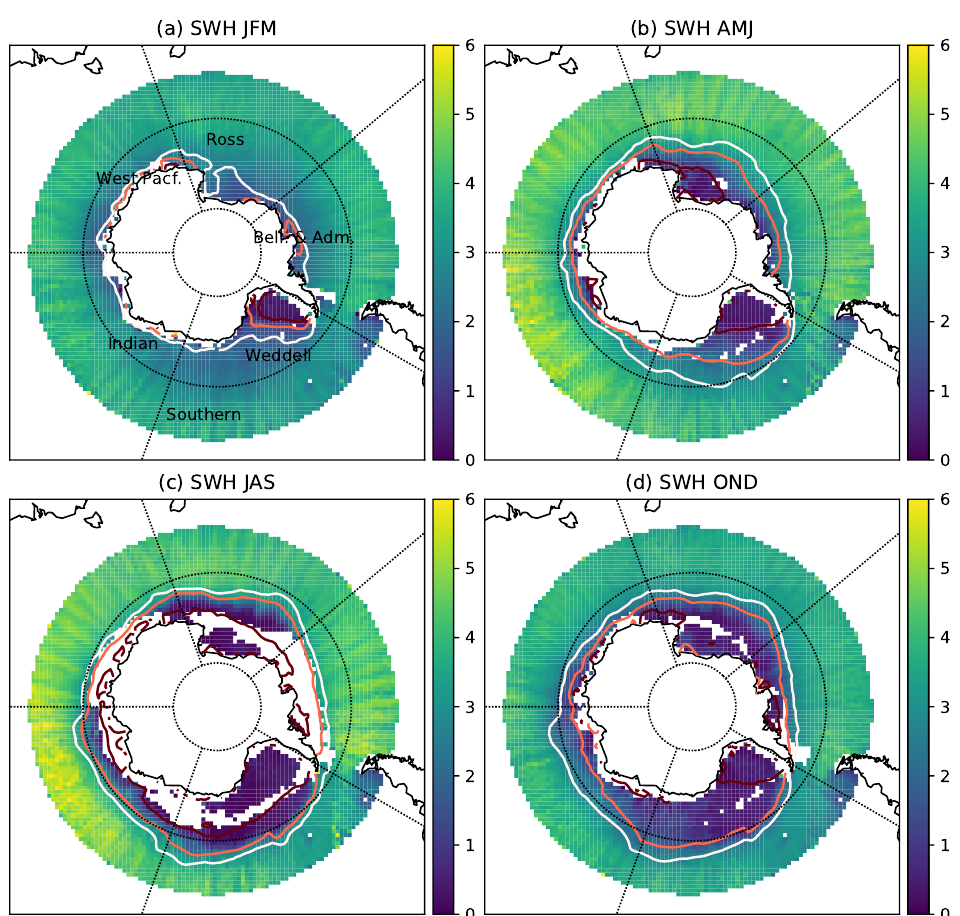
Figure 12. Antarctic climatological maps of retrieved SWH (m) for ( a ) Jan. Feb. Mar., ( b ) Apr. May. Jun., ( c ) Jul. Aug. Sep., ( d ) Oct. Nov. Dec. for the years 2011–2019. Plot ( a ) indicates the regions used in Figure S1 (Supplemental Material). Overlaid on each plots are the contours of 15% 50% and 85% sea NSIDC ice concentration for that quarter. Note that the Weddell, Indian, West Pacific, Ross and Bellingshausen & Admunsen sectors extend only to − 60 ◦ , whilst the Southern Ocean region is over all